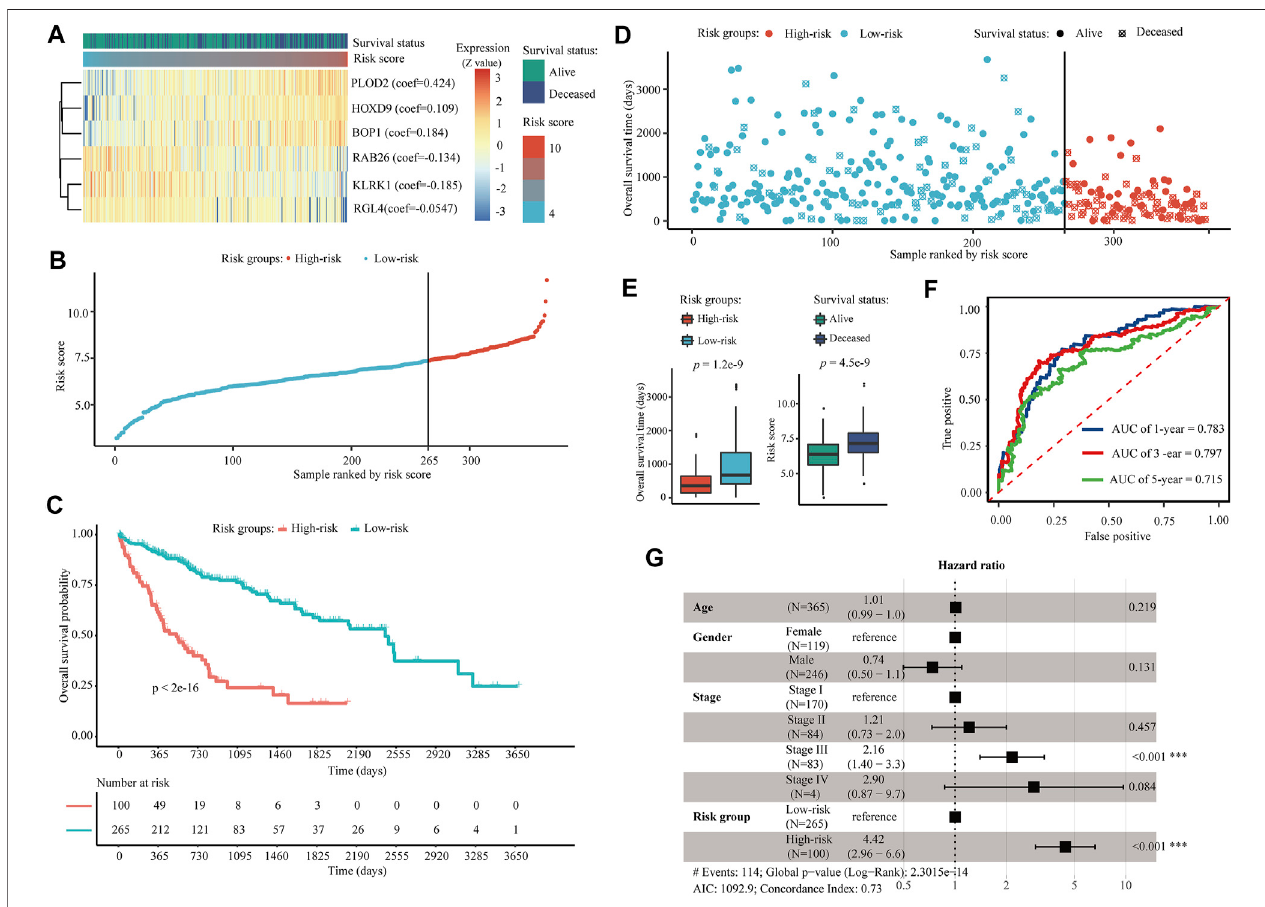
FIGURE7| Construction ofasixAE-DEG-based prognostic model forHCC in TCGA-LIHC. (A) Theexpression heatmap ofsixAE-DEGsconstituted theidenti fi ed prognostic model for OS of HCC in TCGA-LIHC. Multivariate Cox regression derived coef fi cients used for the calculation of risk score are given in parentheses. Patients wererankedaccordingtocorrespondingcalculatedriskscores. (B) DistributionofthecalculatedriskscoresofHCCpatientsinTCGA-LIHC. (C) Kaplan-Meieranalysisof thesixAE-DEG-basedprognosticsignatureinTCGA-LIHC. (D) DistributionofdurationandsurvivalstatusofHCCpatientsinTCGA-LIHC. (E) Boxplotsdisplaythe comparison of survival times between high- and low-risk HCC patients and the comparison of risk scores between alive and deceased HCC patients in TCGA-LIHC. Wilcox p -valueswerecalculatedanddisplayed witheach boxplot. (F) Time-dependent ROCanalysesofthesixAE-DEG-based prognosticsignatureinTCGA-LIHC. (G) Forest plot of the multivariate Cox regression analysis in